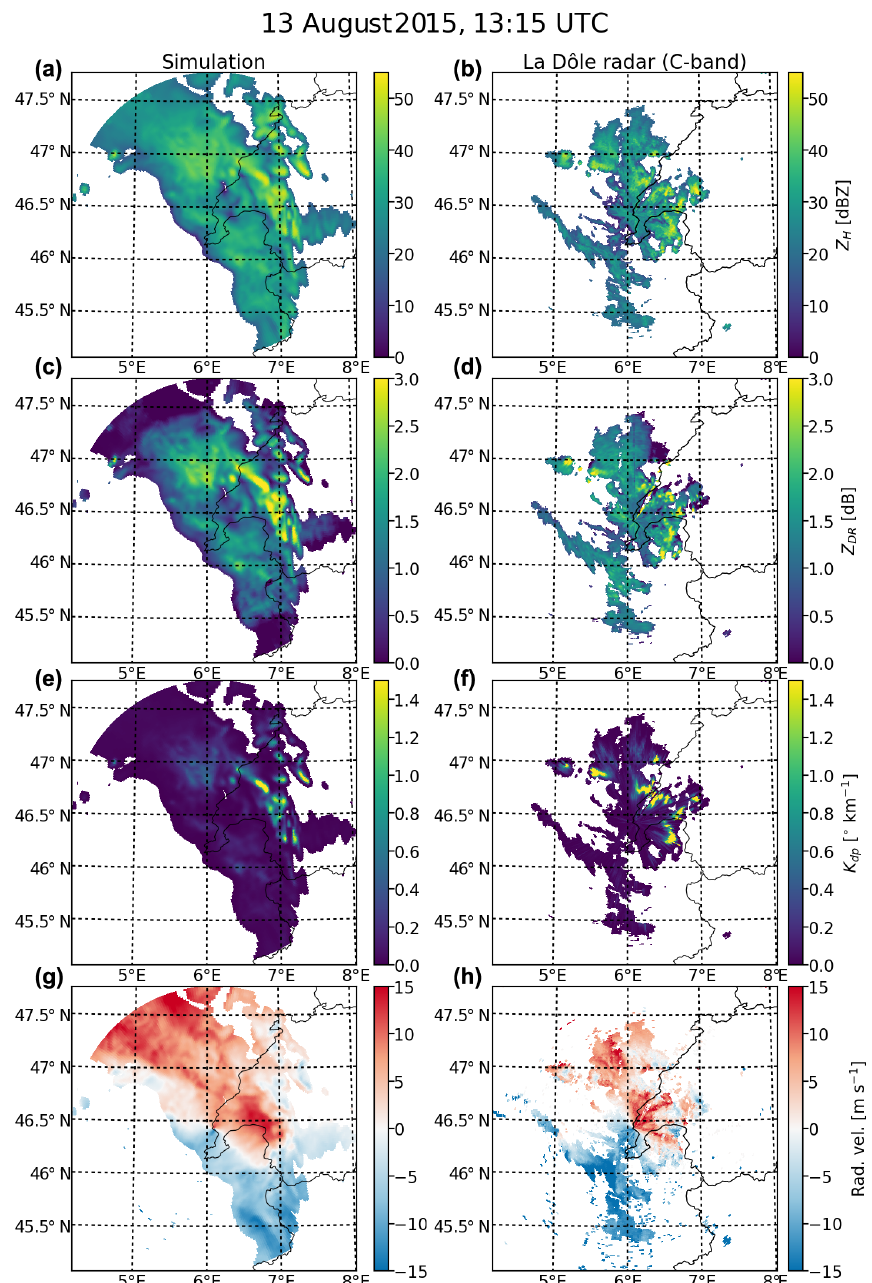
Figure 10. Example of simulated and observed (with the Swiss La Dôle C-band radar) PPI at 1 ◦ elevation during the 13 August 2015 convective event (Table 3). Panels (a, c, e, g) correspond to the simulated radar observables and (b, d, f, h) to the observed ones. The displayed variables are, from top to bottom, the horizontal reflectivity factor (indBZ) (a, b) , the differential reflectivity (in dB) (c, d) , the specific differential phase shift upon propagation (in ◦ km − 1 ) (e, f) , and the radial velocity (in ms − 1 ) (g, h)